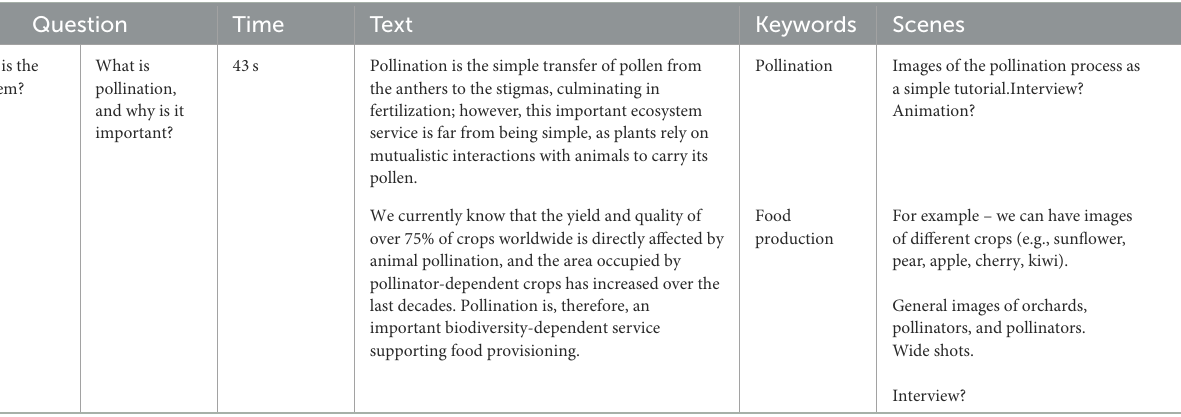
TABLE 1 Script grid using the six-formula question (adapted from Chan,